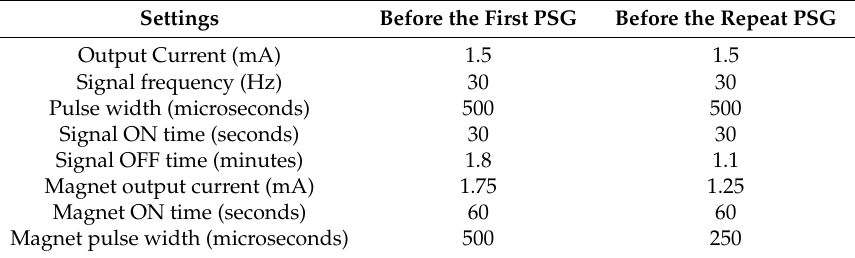
Table 1. Vagus nerve stimulator settings.